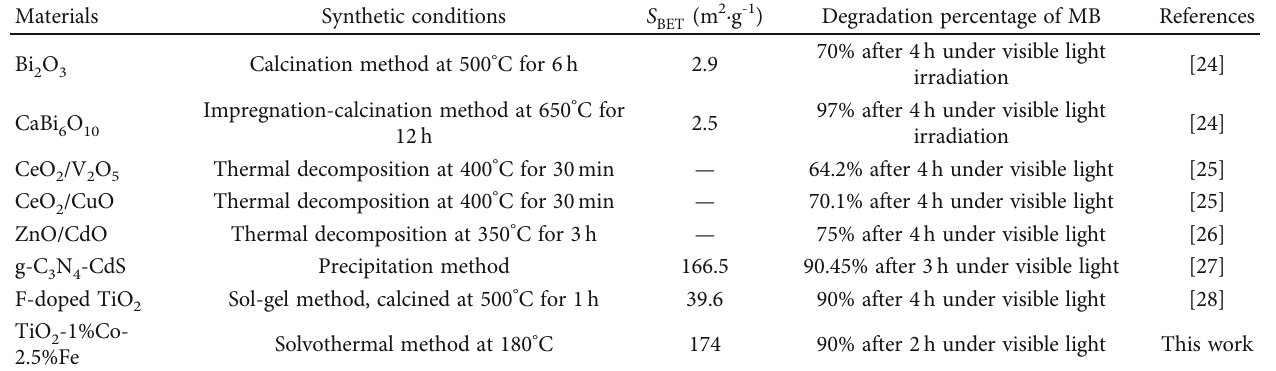
-codoped samples of this work with other materials. 2